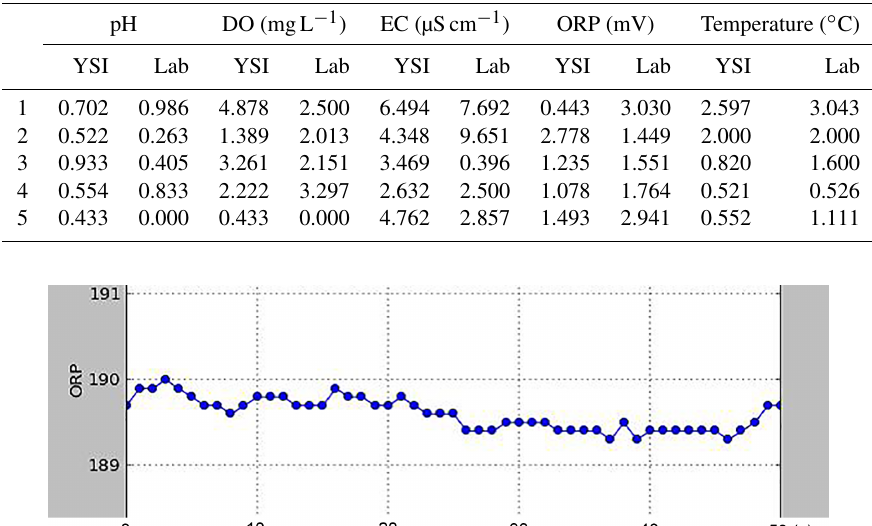
Table 4. MAPE (in %).